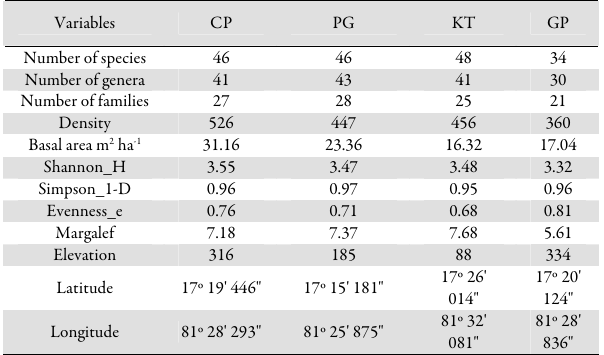
Tab. 1. Number of taxa, diversity indices and structural characteristics of four 1-ha plots in the North-central Eastern Ghats